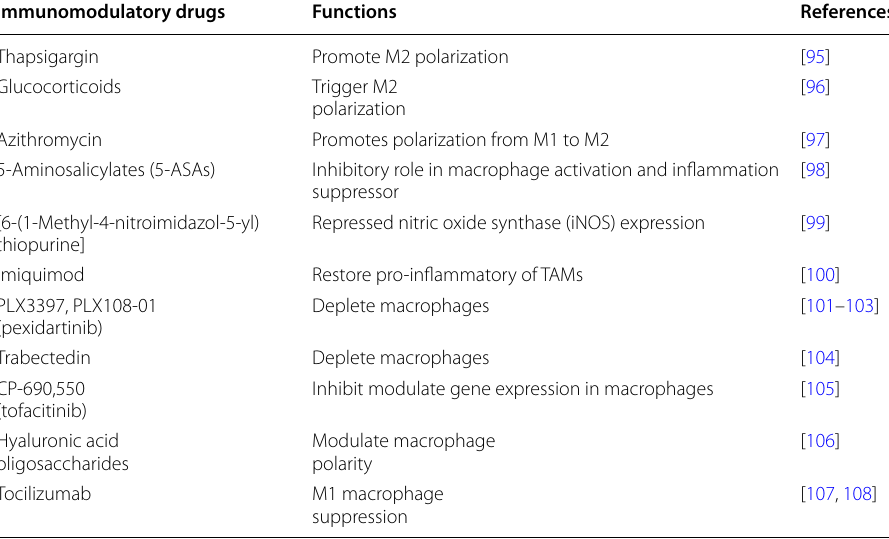
Table 2 Immunomodulatory drugs that target macrophage polarization immunomodulatory drugs Functions Thapsigargin Promote M2 polarization